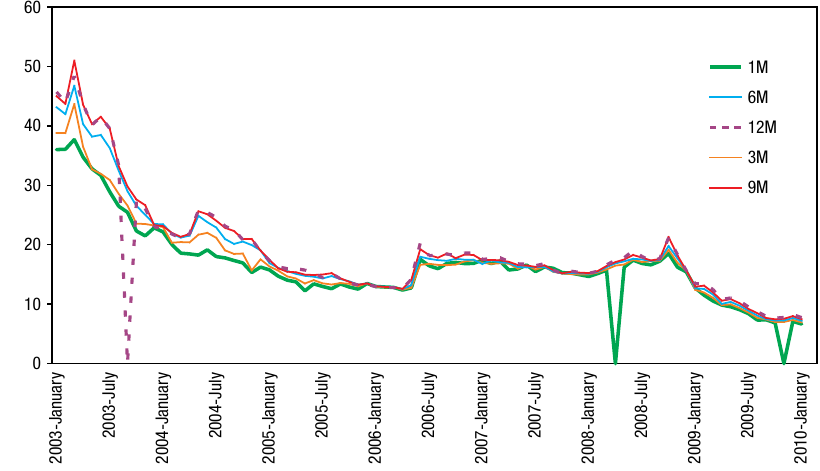
Fig. 1. 1, 3, 6, 9 and 12 Month Yields for January 2003–January 2010